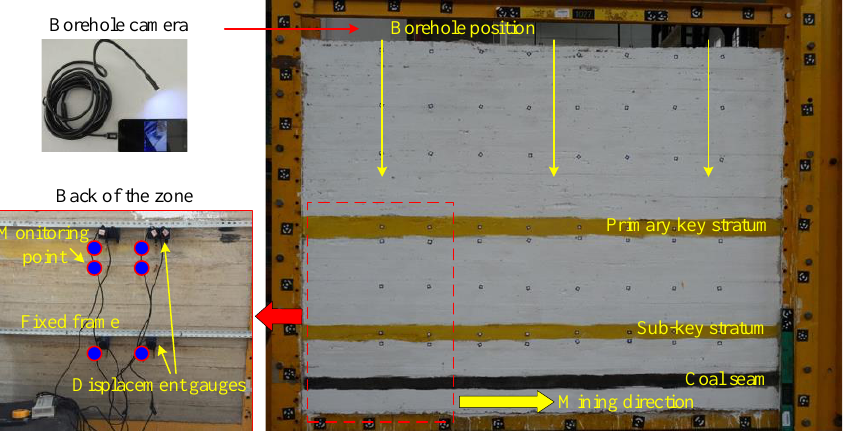
Figure 5. Configuration of the physical model and the installation of the monitoring devices.